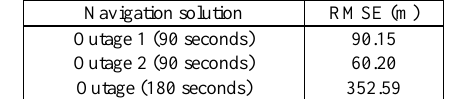
Table 5. Position RMSE for INS standalone navigation solution